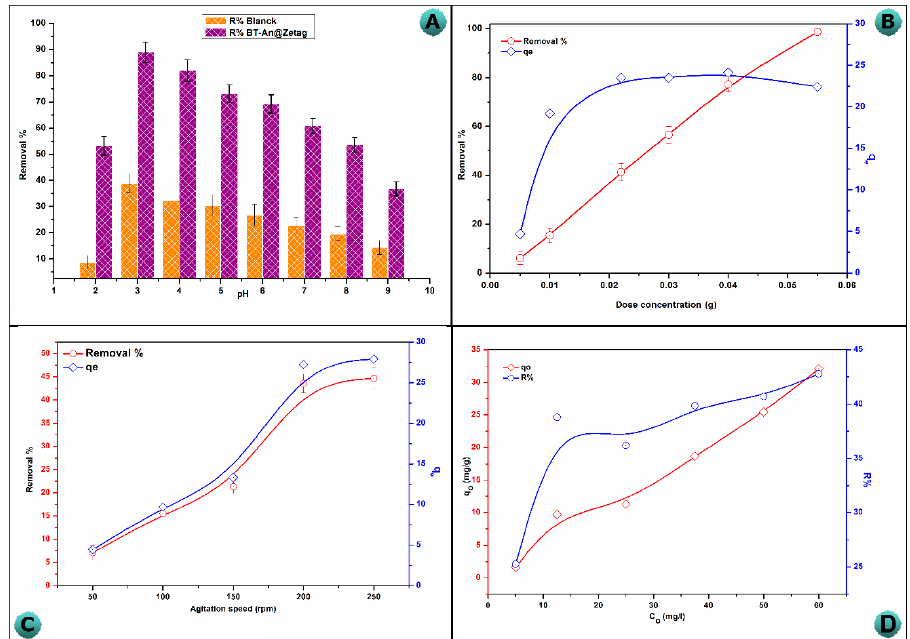
Figure 4. ( A ) The effect of solution pH on As(V) adsorption by BT-An@Zetag composites (Concen- tration: 50 mg/L, adsorbent weight: 20 mg, contact time: 120 min, and agitation speed: 200 rpm at 25 °C), and effect of ( B ) adsorbent doze, ( C ) agitation speed, and ( D ) initial concentration on As(V) adsorption by the BT-An@Zetag composite.